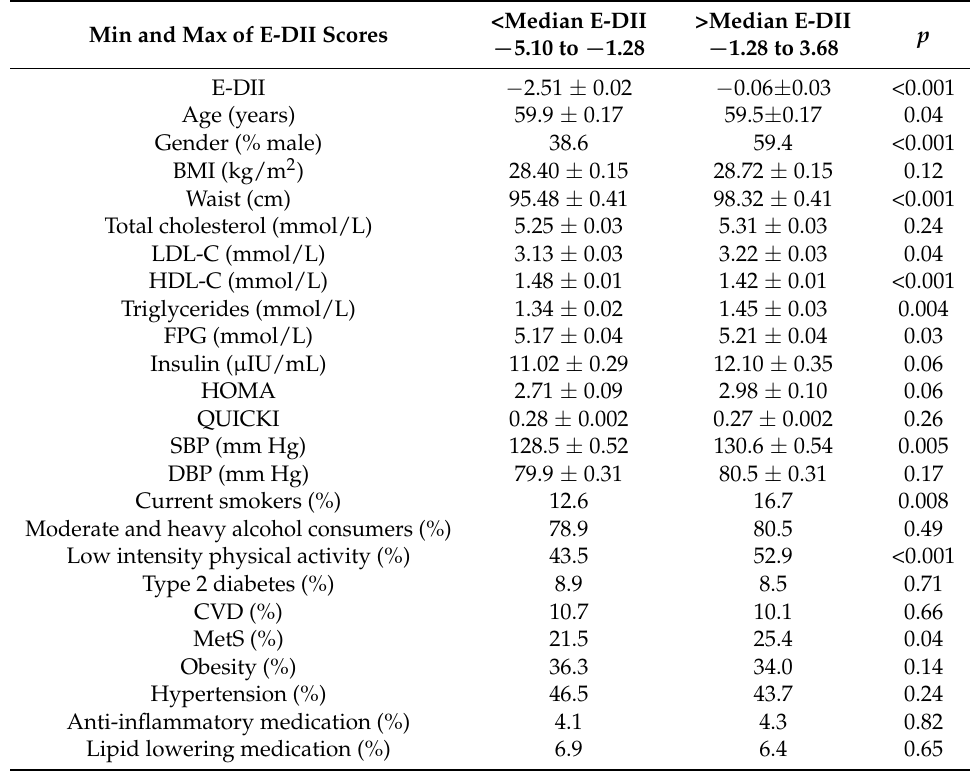
Table 1. Characteristics of the Mitchelstown cohort ( n = 1992) by E-DII median. Min and Max of E-DII Scores